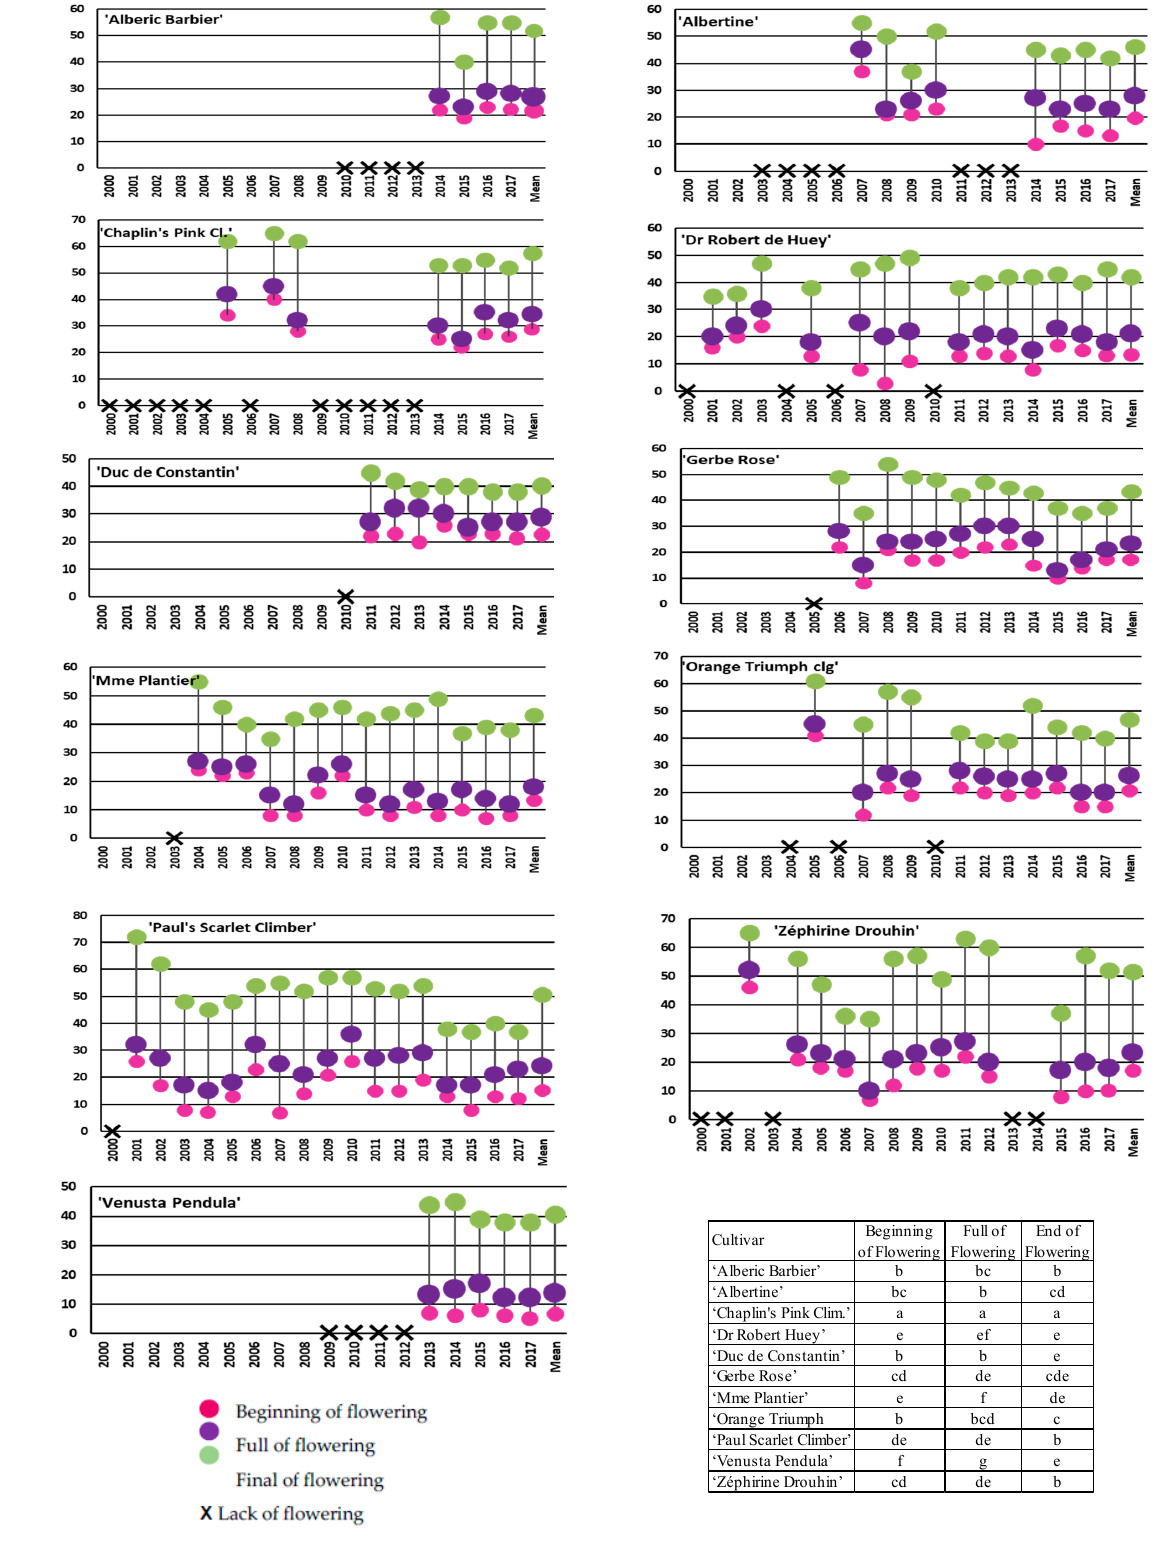
Figure 7. The beginning of flowering (BBCH 60,601), full flowering (BBCH 63,605), and its end (BBCH 69,609) in climber roses in the years 2000–2017. The numbers on the Y-ray indicate fallowed days where the first day starts at the 25 May. Different letters marked significant differences between cultivars, in respect Duncan’s test ( α = 0.05). Table 11. Correlations matrix between frost damage, early phenology stages, and beginning and abundance of flowering in climber roses for all cultivars taken together (‘Alberic Barbier’, ‘Albertine’, ‘Chaplin’s Pink Climber’, ‘Dr Robert Huey’, ‘Duc de Constantin’, ‘Gerbe Rose’, ‘Mme Plantier’, ‘Orange Triumph clg’, ‘Paul Scarlet Climber’, ‘Venusta Pendula’, and ‘Zéphirine Drouhin’).